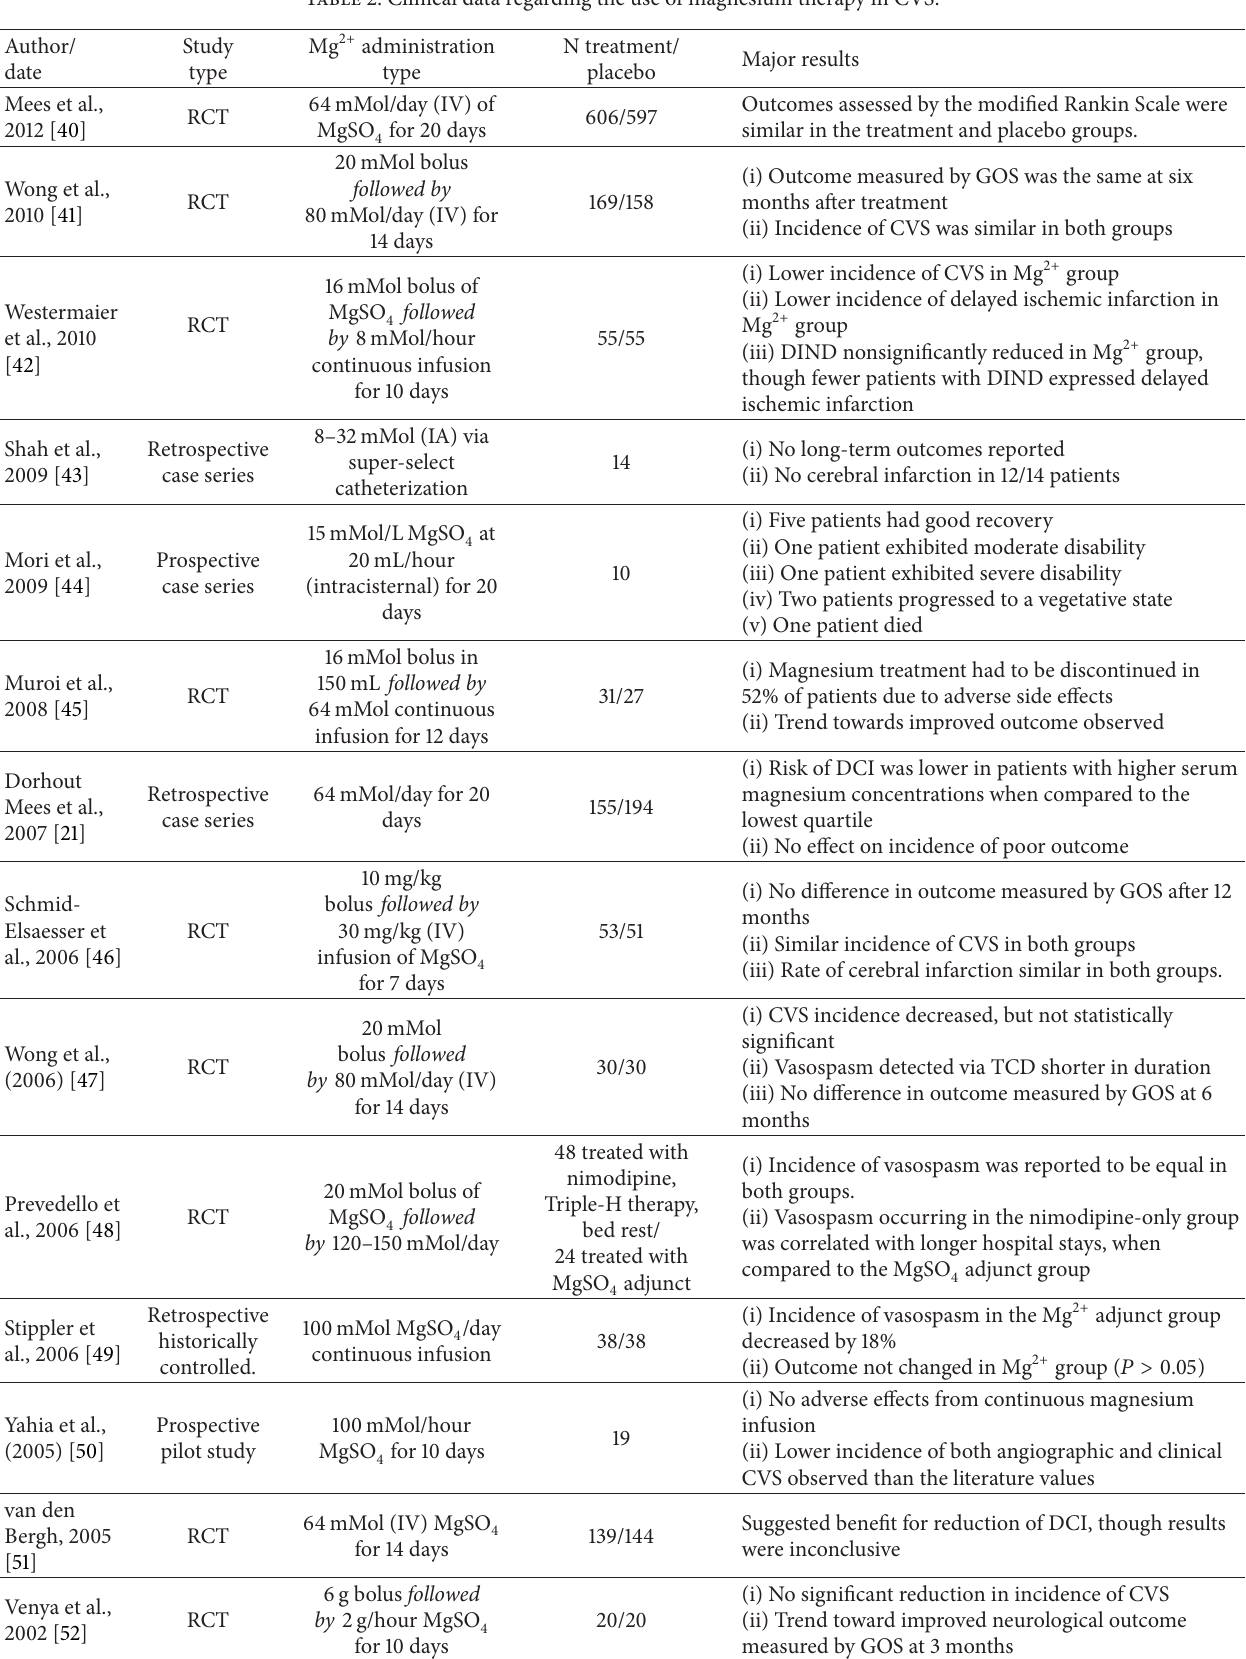
Table 2: Clinical data regarding the use of magnesium therapy in